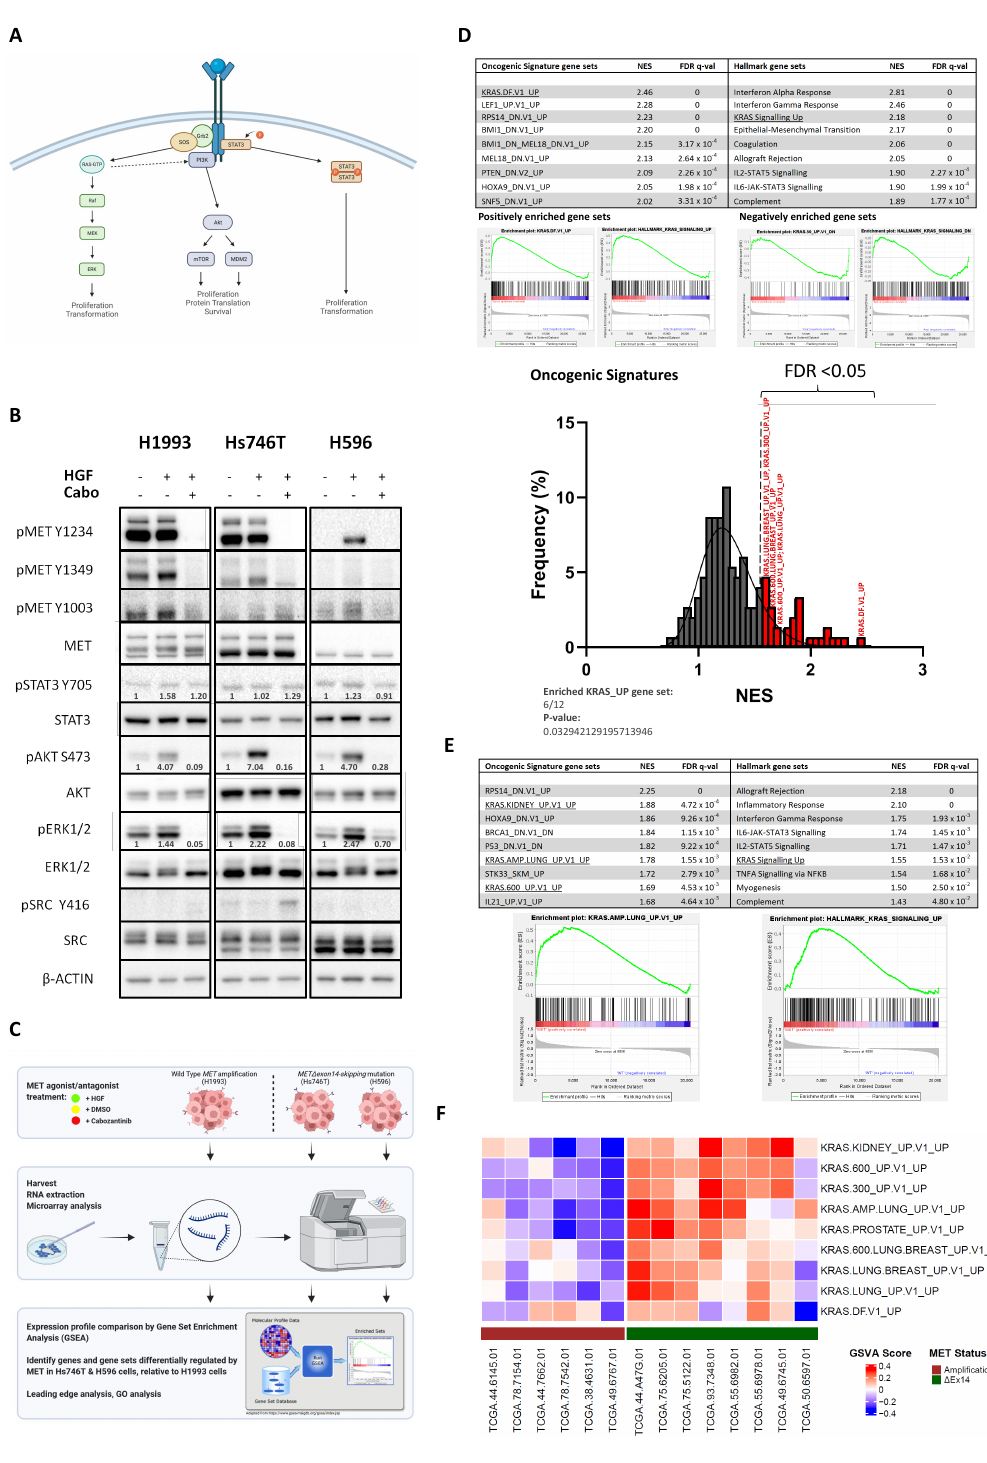
Figure 1. MET ∆ ex14 variant-expressing cancers exhibit an enhanced KRAS activation